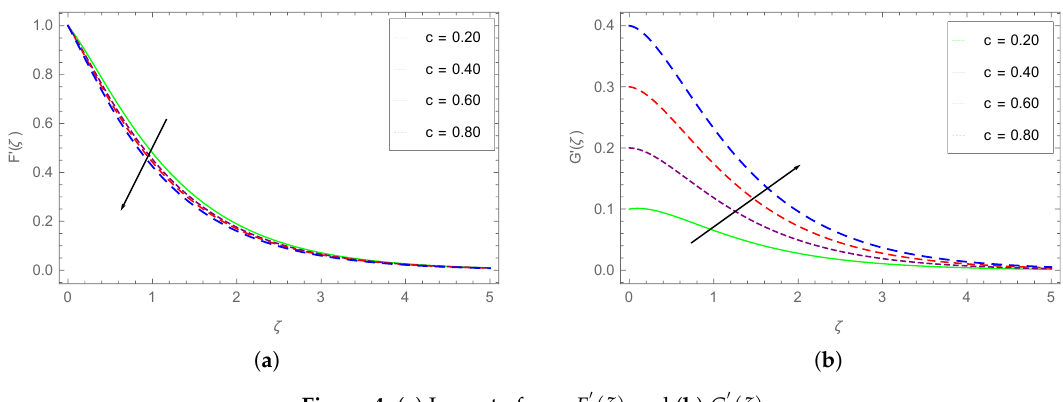
Figure 4. ( a ) Impact of c on F (cid:48) ( ζ ) and ( b ) G (cid:48) ( ζ )